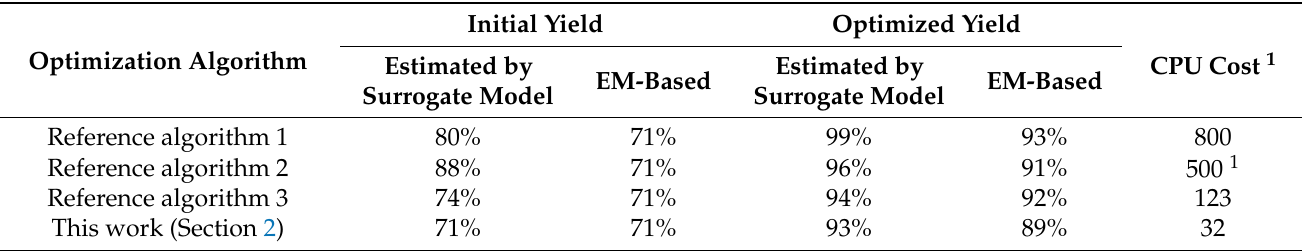
Table 4. Design centering results for Circuit III (Figure